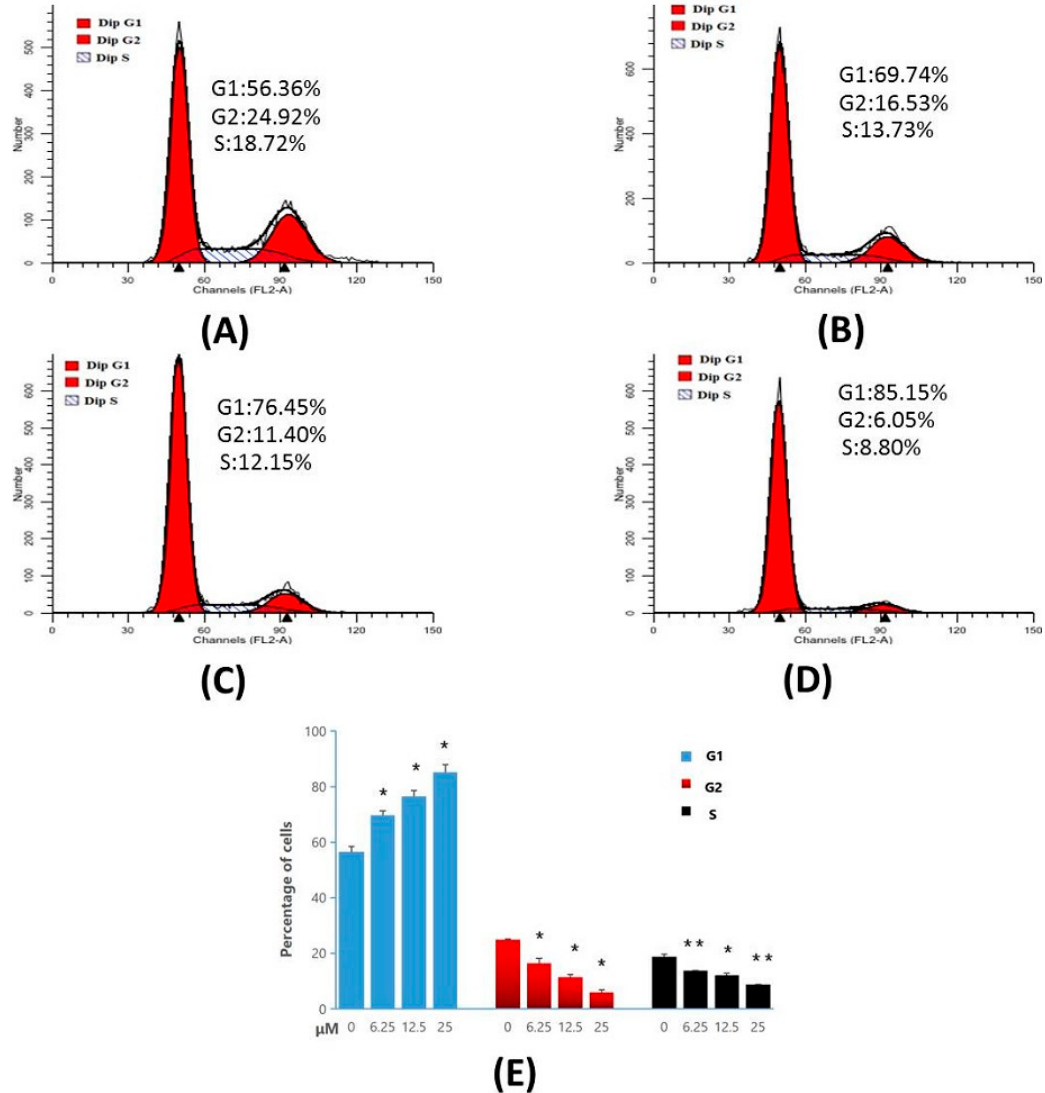
Figure 7. Cell-cycle analysis of MT-4 cells treated with Compound 4d , by flow cytometry. ( A ) Not treated with Compound 4d (control) for 48 h ( B ) treatment with Compound 4d at 6.25 µ M, ( C ) treatment with Compound 4d at 12.50 µ M and, ( D ) treatment with Compound 4d at 25 µ M for 48 h each, respectively, ( E ) The percentage of each population was shown as mean ± SD. Data is the representative of three independent experiments. * p < 0.05, ** p < 0.01.